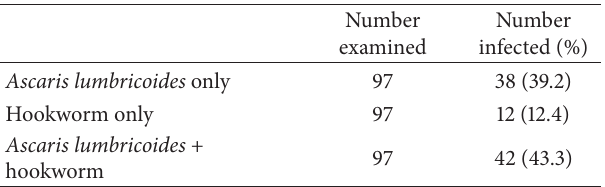
Table 2: Prevalence of geohelminths infection among the surveyed preschool aged